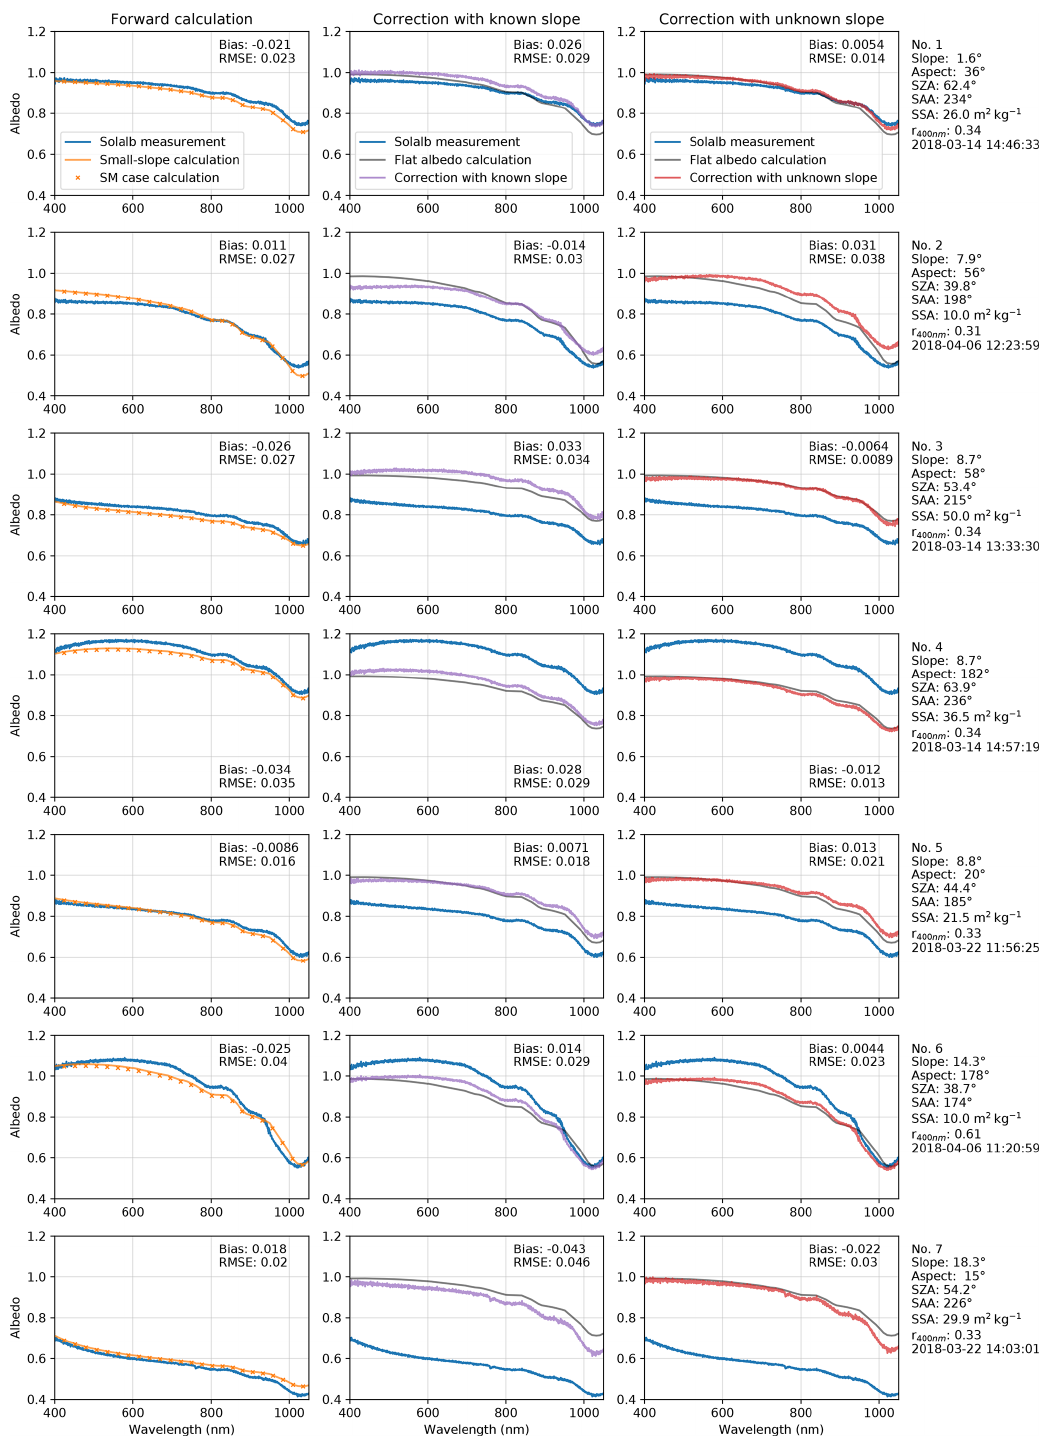
Figure 5. Measured, calculated, and corrected albedo for seven acquisitions (rows) taken in different terrain configurations. The first column compares apparent albedo calculated from the theory (small slope and SM case) to measured albedo. The second column compares corrected albedo using measured slope parameters to intrinsic diffuse albedo calculated for a flat surface using measured SSA (grey). The third column is similar to the second column, except that the measured albedo is corrected without using measured slope parameters but by assuming clean snow. The second and third columns also show measured albedo to highlight the change due to the